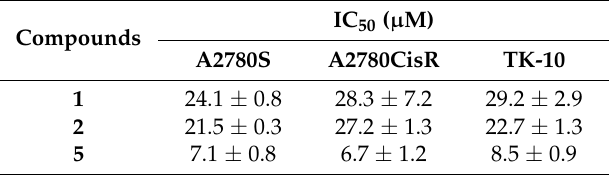
Table 3. Antiproliferative activities of compounds 1 , 2 , and 5 against different cell lines.